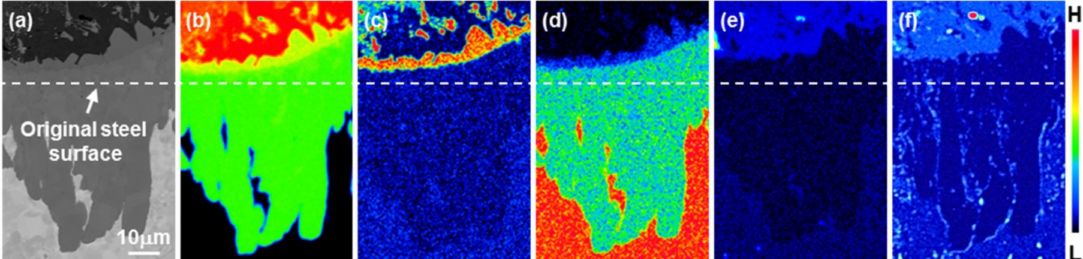
Figure 12. ( a ) BSE image and ( b – f ) results of the EPMA area analysis of the specimen hot-dipped for